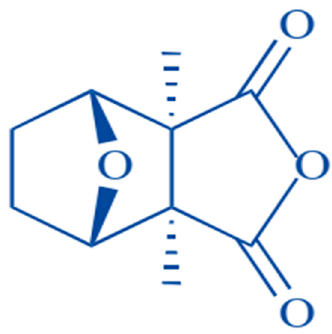
Figure 1. Chemical structure of cantharidin [20].